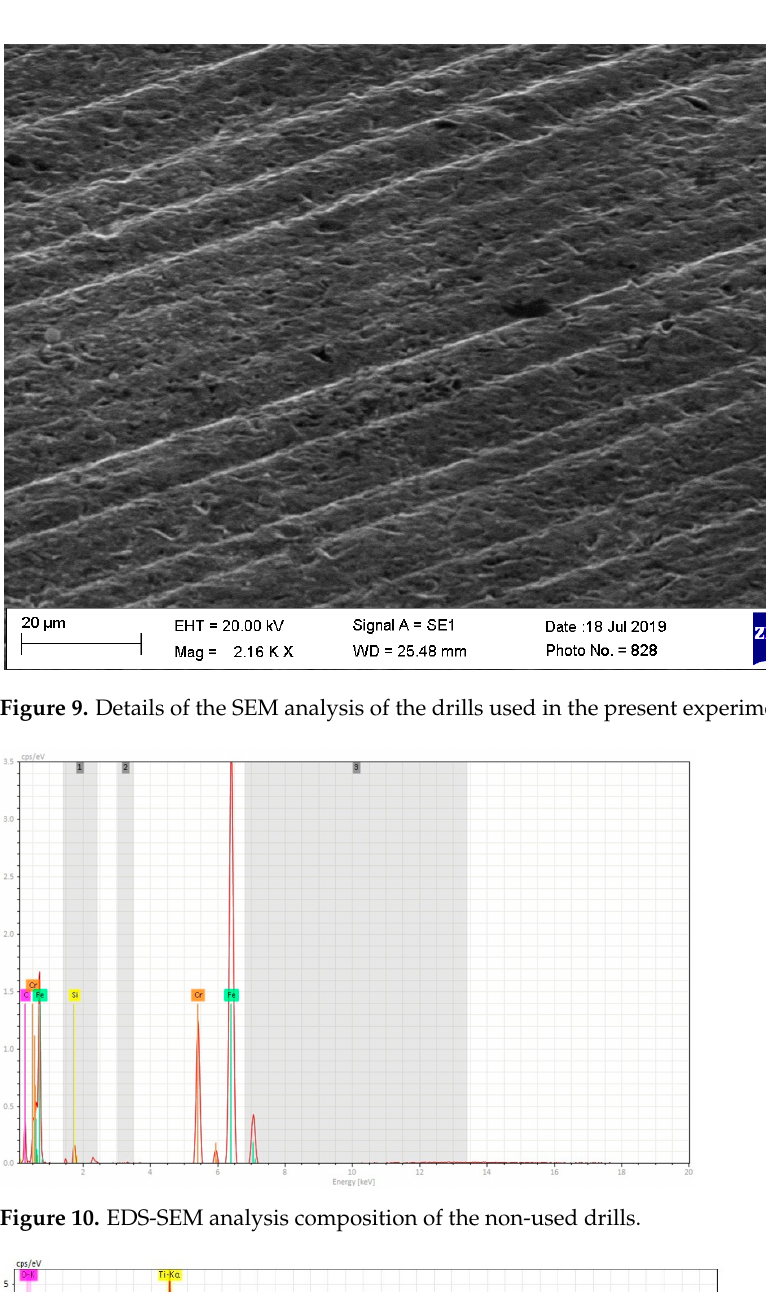
Figure 8. Details of the SEM analysis of the drills used in the present experiment.